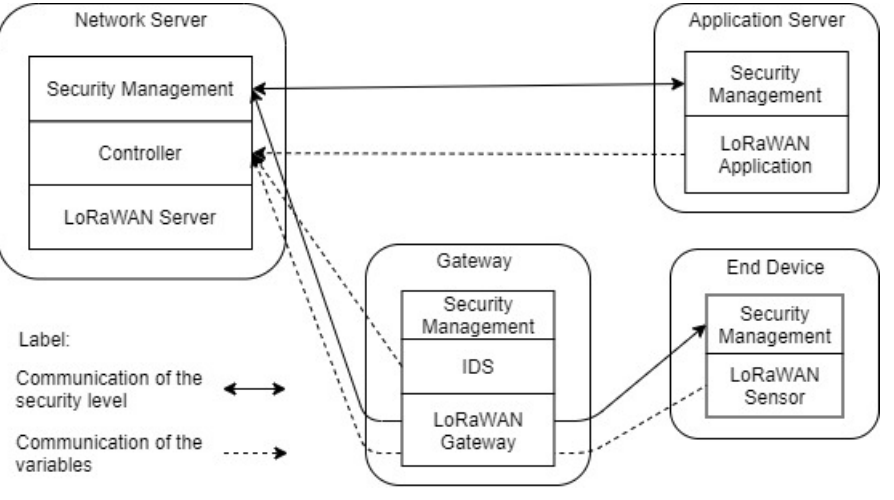
Figure 2. System view of the proposed architecture.